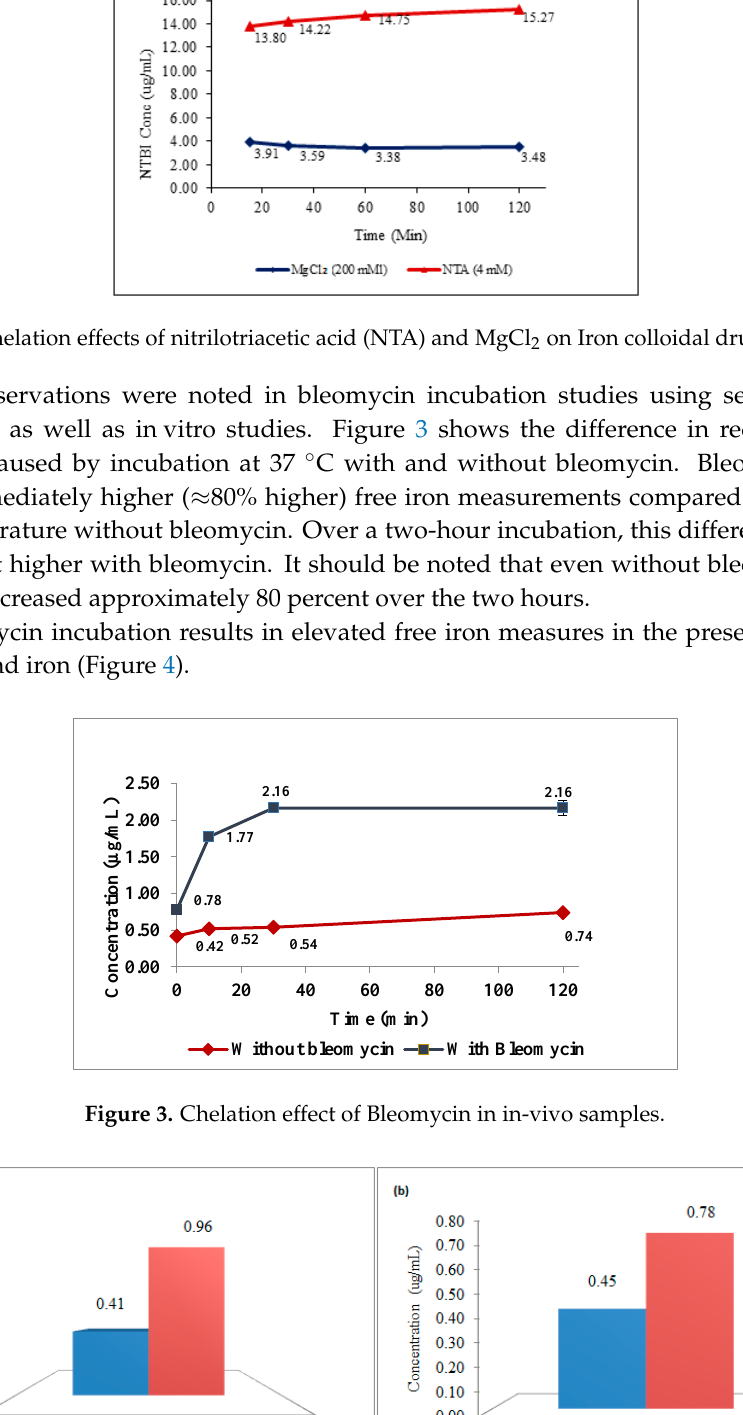
Figure 4. Chelation effect of bleomycin on ( a ) Iron colloidal drug; ( b ) Transferrin bound iron.